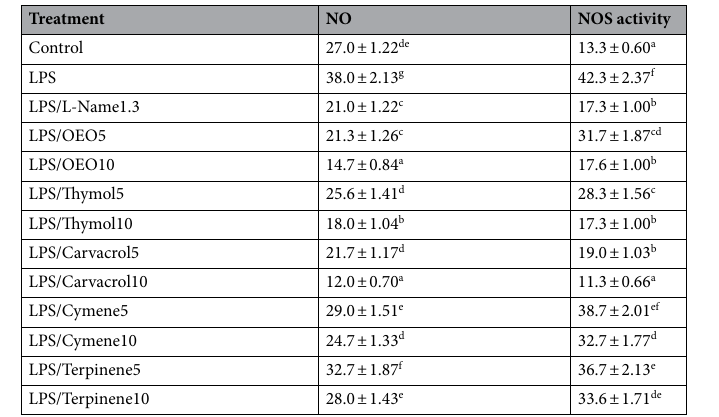
Table 4. Effects of OEO, main components at different concentrations (5 and 10 µg/ml), and positive control (L-NAME, 1.3 μg/ml) on NO production and NOS activity in LPS-stimulated macrophages. The values are expressed as means ± SDs for three replicate experiments. Mean values with different letters within a column are significantly different by the Tukey test at ( p < 0.05). This test classifies the treated groups into letters. Groups that have little significant difference have similar letters and those with more significant difference receive different letters.